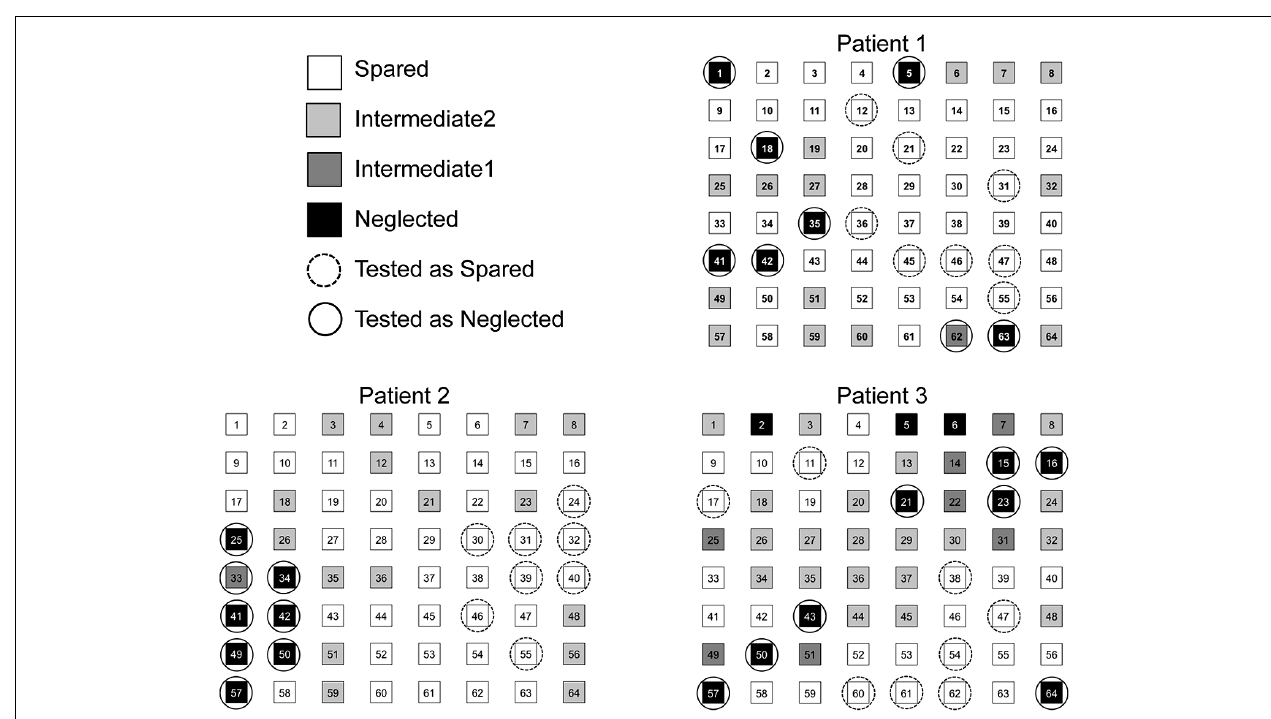
FIGURE 2 | Maps of Spared locations (white, correctly discriminated 3/3 times), Intermediate2 locations (light gray, correctly discriminated 2/3 times), Intermediate1 locations (dark gray, correctly discriminated 1/3 times), and neglected locations (black, correctly discriminated 0/3 times)